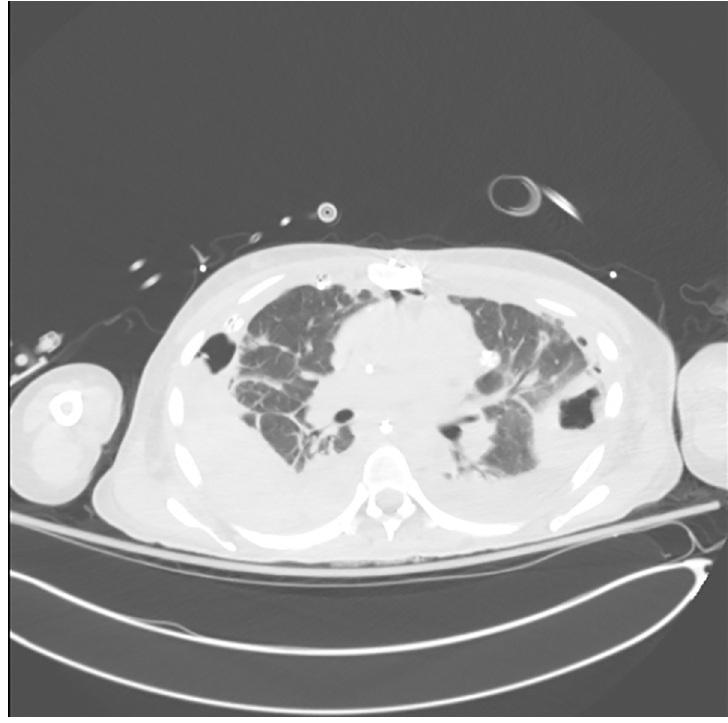
Fig 2. Bilateral cavitary lesions. Axial computed tomography scan depicting bilateral cavity lung lesions consistent with lung abscesses and empyema in a patient with tricuspid valve endocarditis and history of injection drug use.